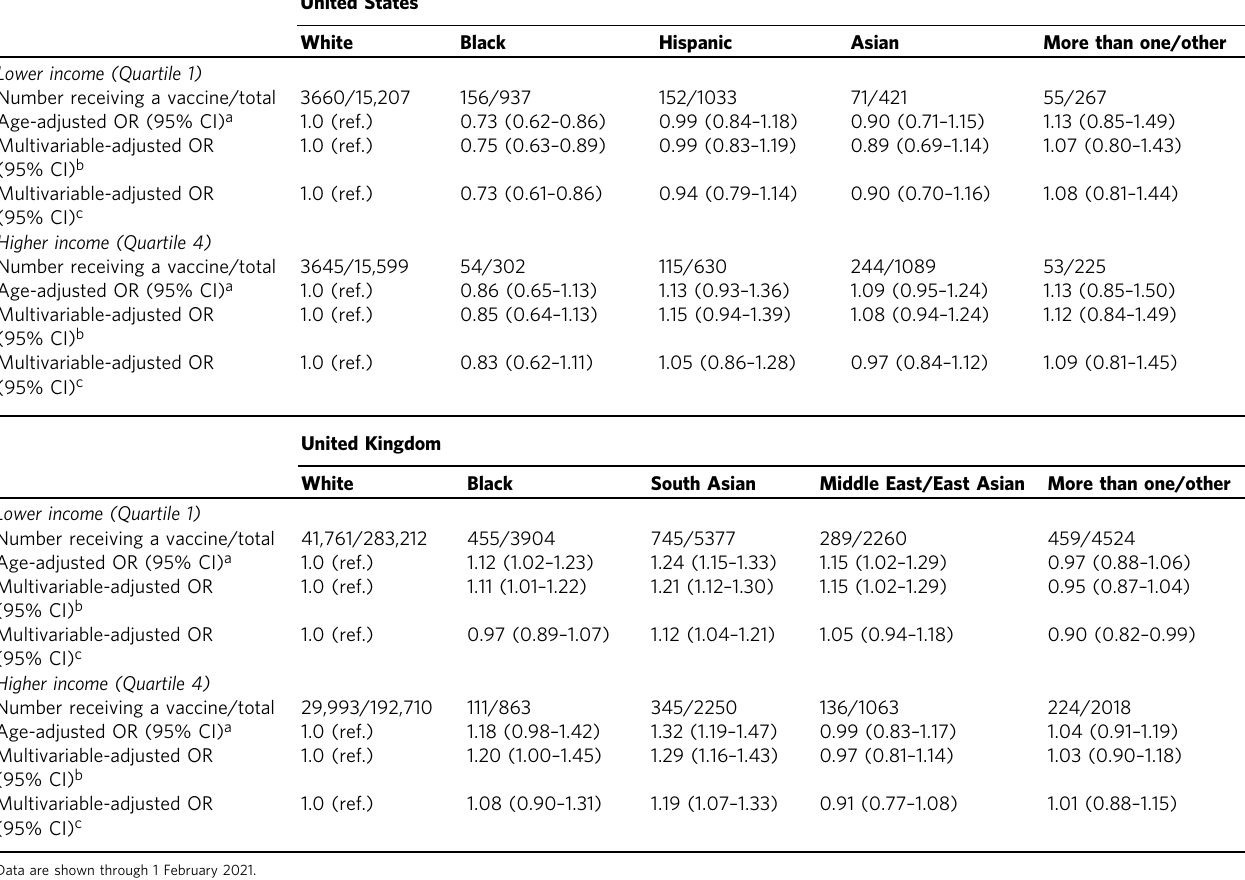
Table 5 Vaccine uptake by race and ethnicity according to country of enrollment by economic